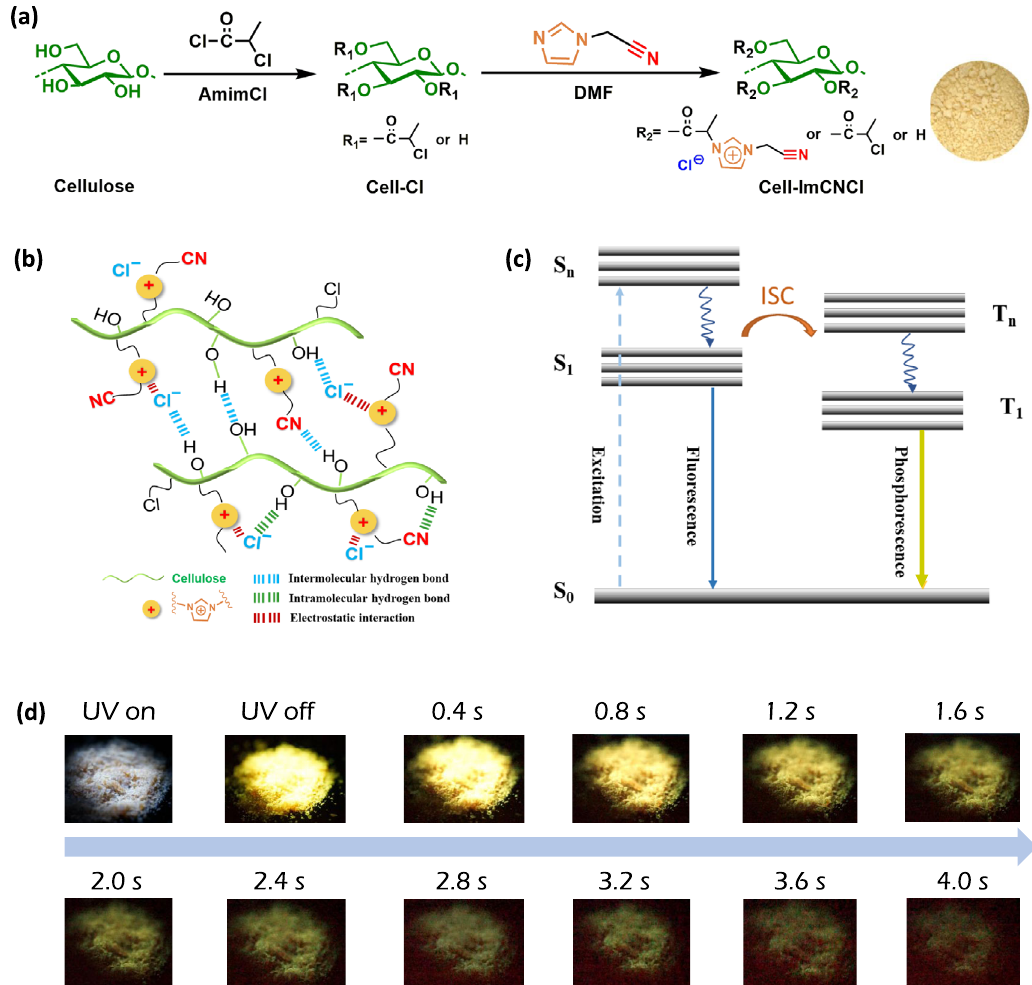
Fig. 2 Synthesis, RTP mechanism, and performance of Cell-ImCNCl. a Synthesis route and photograph of Cell-ImCNCl; b Schematic illustration of the RTP mechanism of Cell-ImCNCl; c Jablonski diagram energy level diagram of RTP materials; d Photographs of Cell-ImCNCl powder taken under 365 nm lamp and with the lamp